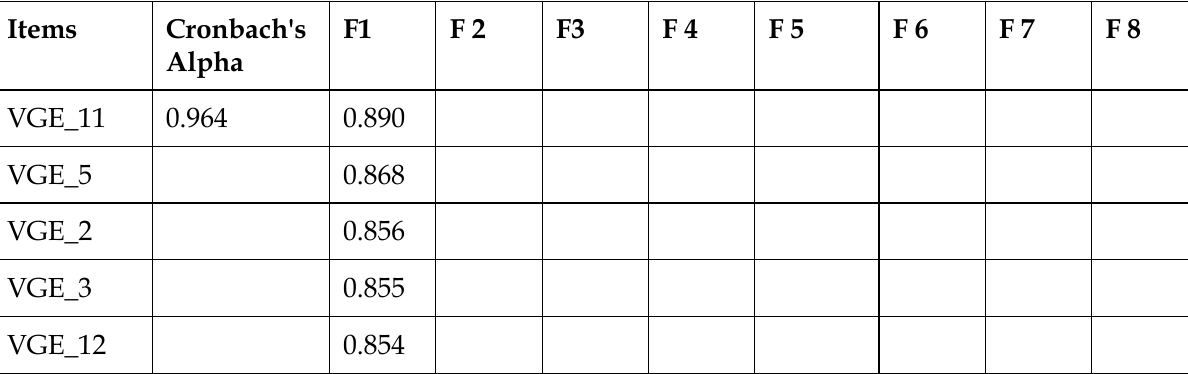
Table 4: Dimensionality analysis